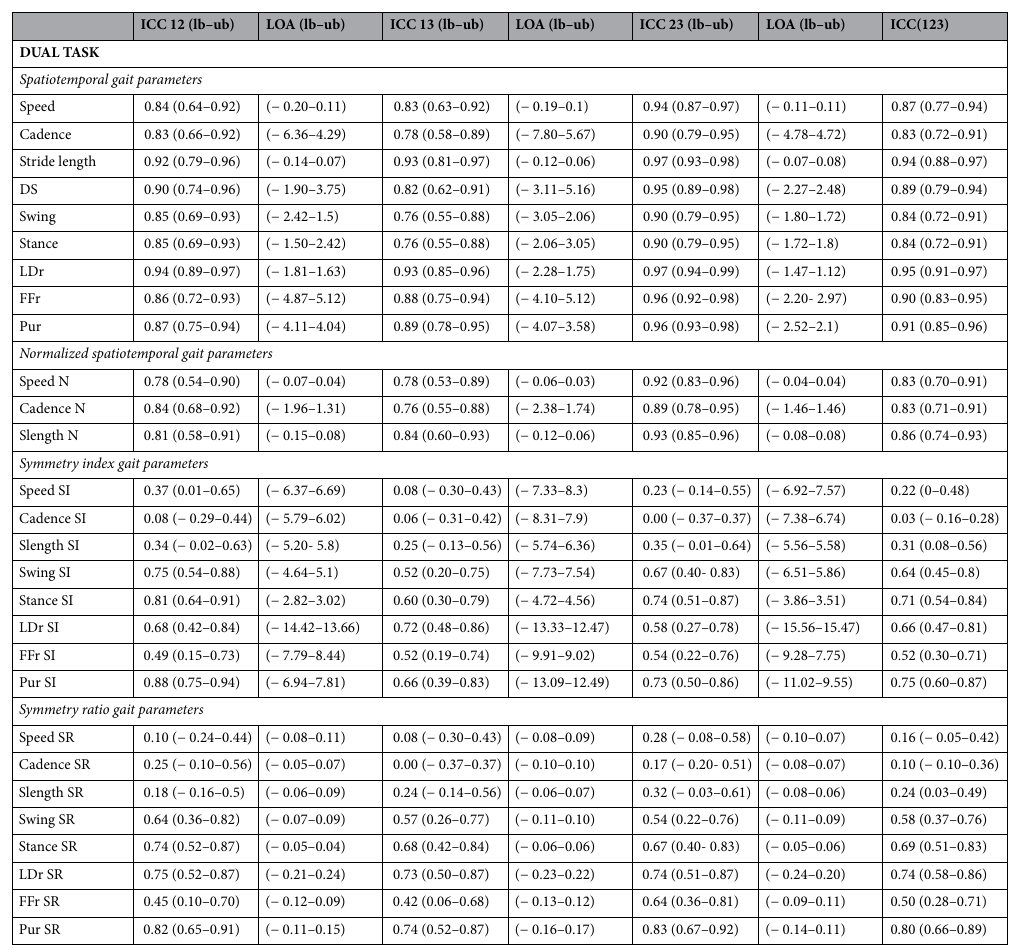
Table 3. Intraclass correlation coefficients (ICC) and limits of agreement (LOA) values for spatiotemporal gait parameters obtained in dual task condition between the mean of the first and second trials (T1-T2), the first and the third trials (T1-T3), the second and the third trials (T2-T3) and the means of the three consecutive trials (T1-T2-T3). Abbreviations: ICC = intraclass correlation coefficient, LOA = limits of agreement, SI = symmetry index, SR = symmetry ratio, lb = lower bound, ub = upper bound, DS = double support, LDr = Load Ratio, FFr = Foot flat ratio, Pur = Push ratio, N =